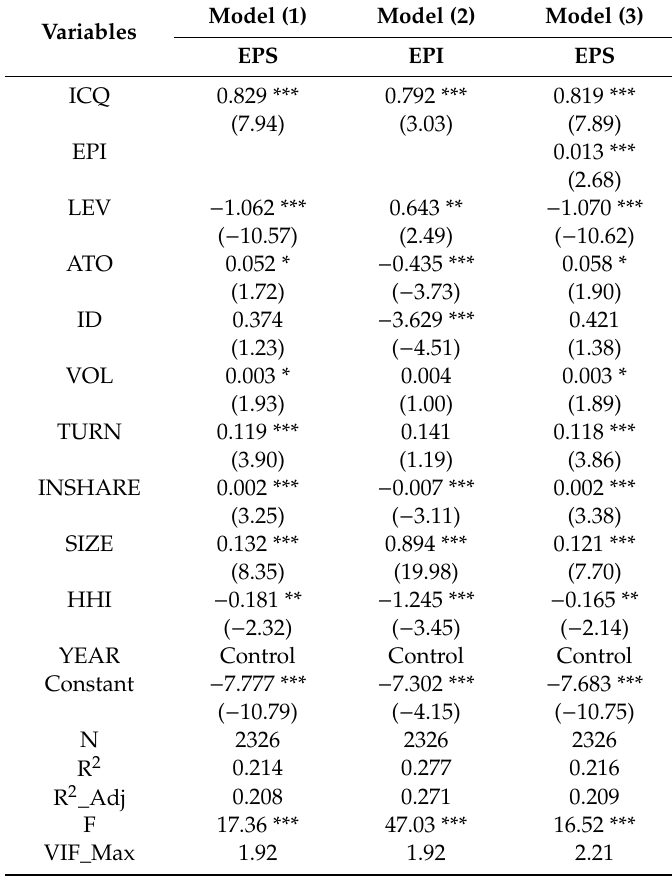
Table 4. Regression coe ffi cient and results of each